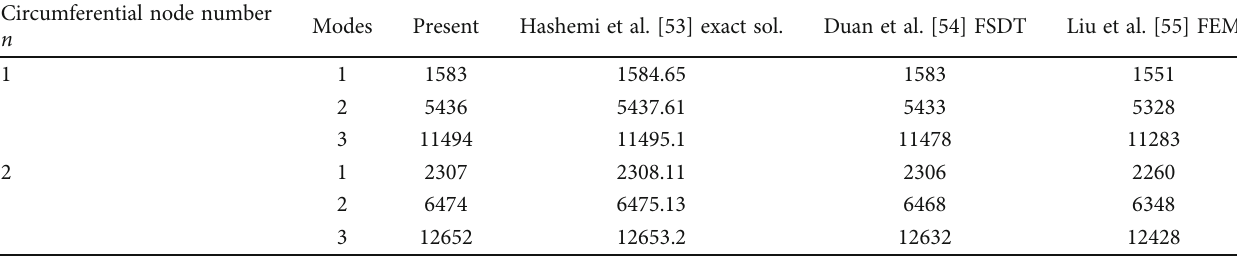
ffiffiffiffiffiffiffiffiffiffiffiffi p with Hashemi et al. [53], Duan et al. [54], I 0 / A 11